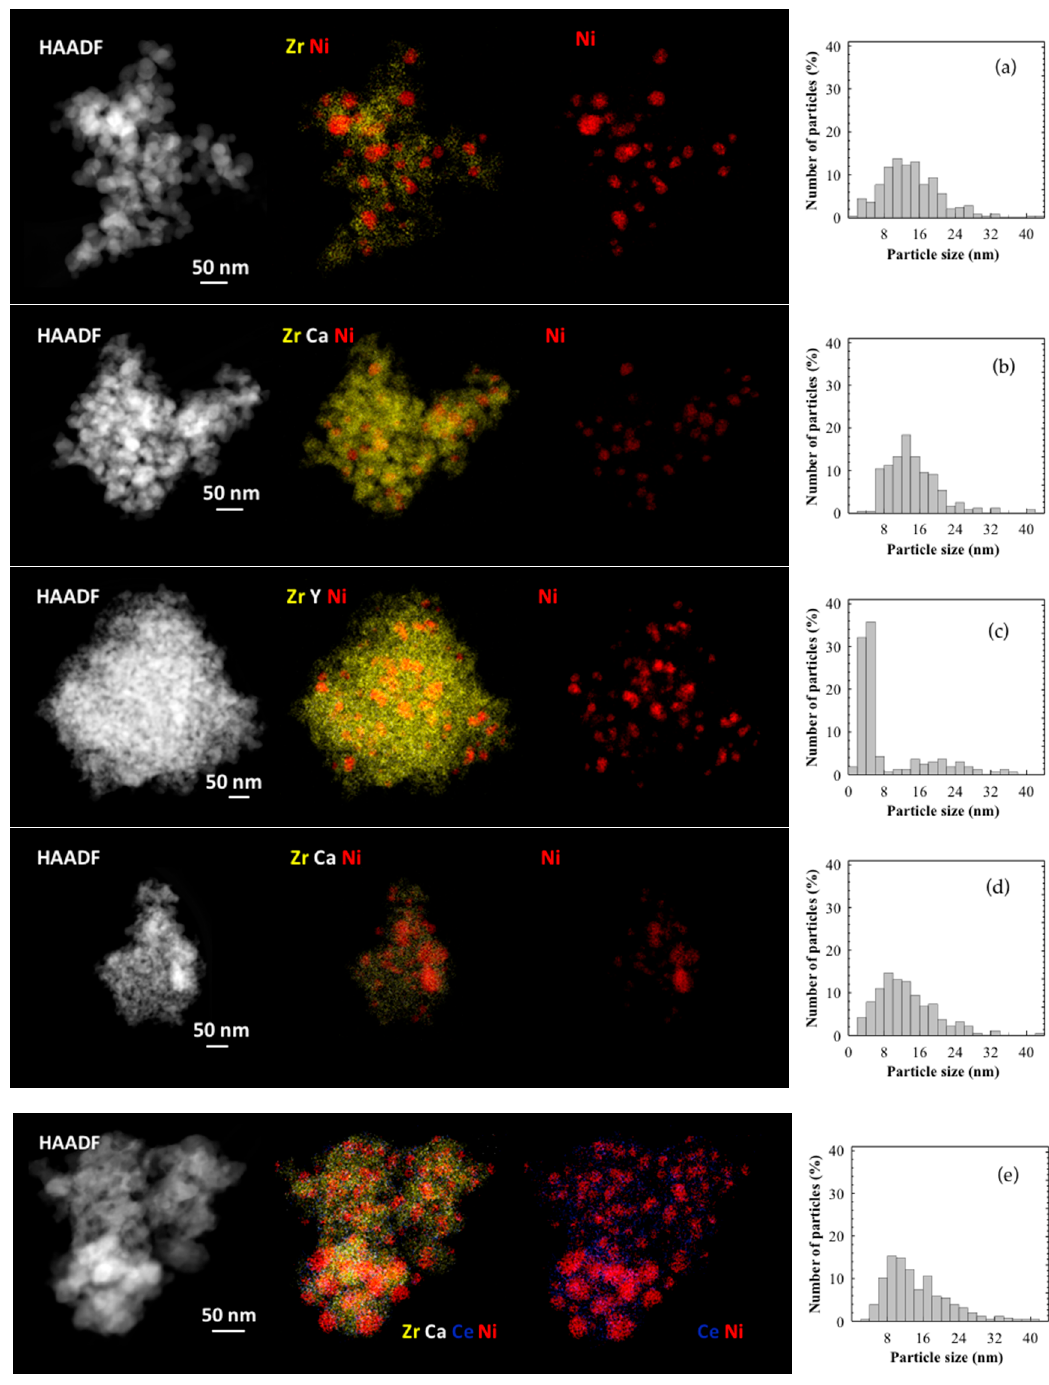
Figure 6. HAADF images, EDS mappings, and particle size distributions of: ( a ) NiZr; ( b ) Ni4CSZ; ( c )